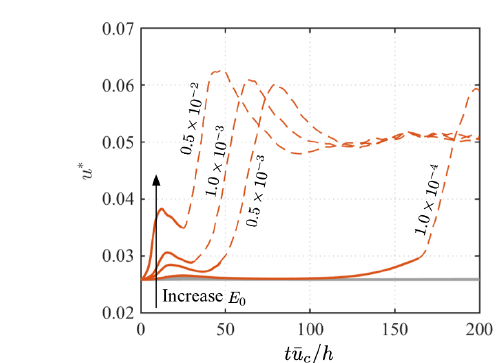
Figure 7. Time evolution of friction velocity u ∗ of case ( α , β ) = ( 1,0 ) initialized by different amplitudes of optimal disturbance E 0 : Red lines represent transition cases, and grey lines denote that the flow remains laminar. Dashed line indicates that the flow is in turbulent state.